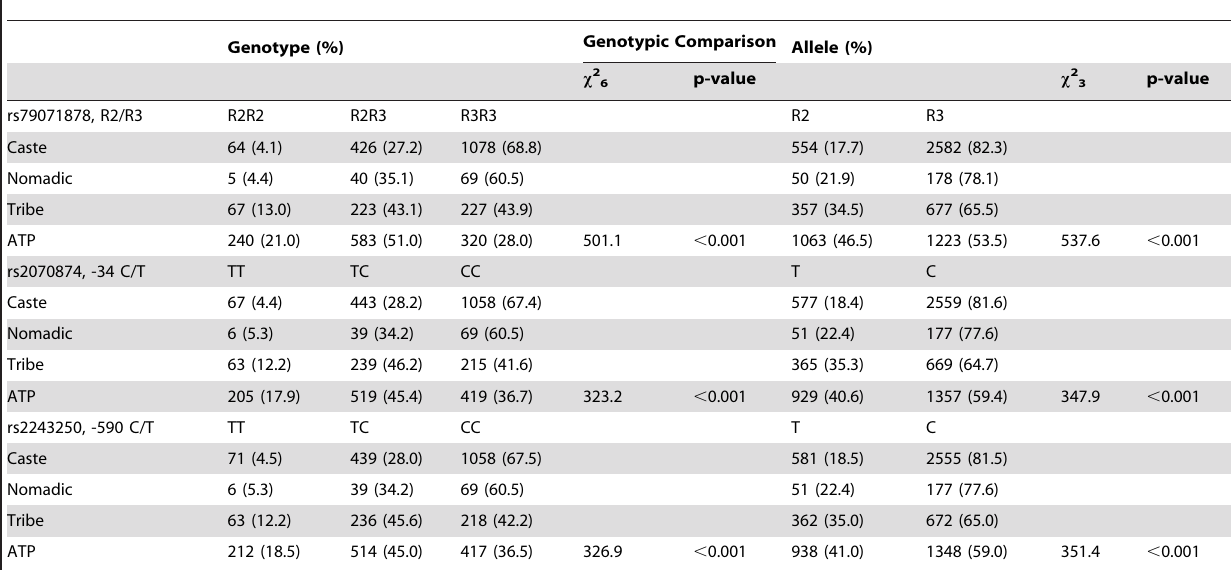
Table 6. Genotype and allele distribution of IL-4 intron-3 VNTR polymorphism, -34CT and -590CT in various groups of Indian